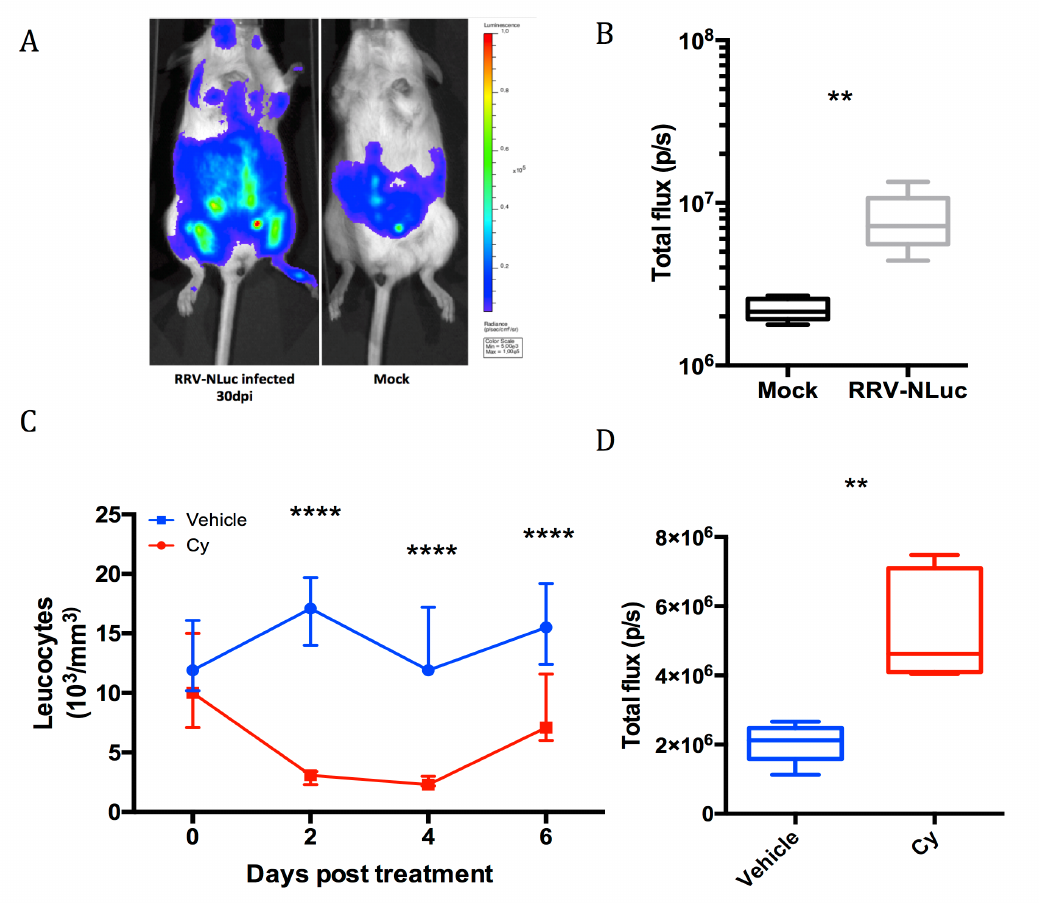
Figure 5. RRV chronic infection is revealed by luminescence of RRV-NLuc and cyclophosphamide immunosuppression. Groups of five mice were infected with 10 3 pfu RRV-NLuc and monitored for bioluminescence from 30 dpi. ( A ) In vivo imaging of RRV-NLuc infected (left) and mock inoculated (right) mice at 30 dpi; ( B ) total flux counts on the whole body of RRV-NLuc infected and mock-inoculated mice at 30 dpi. The infected group exhibits a significant bioluminescent signal (** = p < 0,01 Mann-Whitney); ( C ) leucocytes counts after Cy immunosuppressive (red) treatment or (blue) vehicle, median and range are represented (**** = p < 0.0001 two way ANOVA) and ( D ) increase in the total flux counts at 6 dpi after Cy treatment (** = p < 0.01,